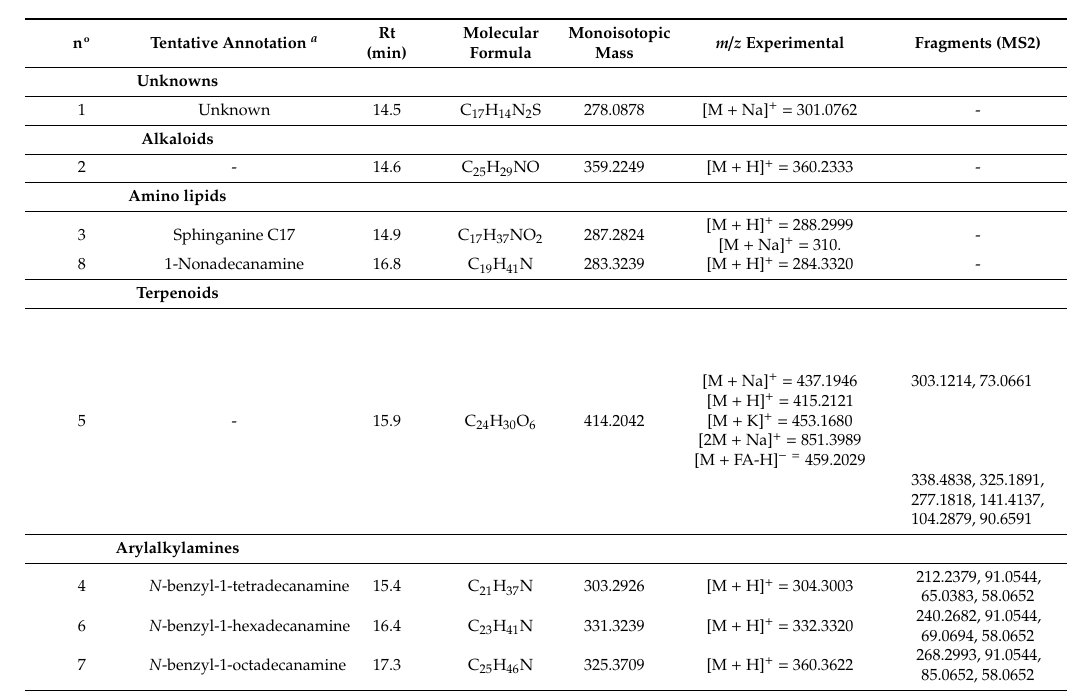
Table 4. Retention times, mass spectral data and characterizations of the detected compounds in the UHPLC / ESI–QTOF–MS analysis in positive and negative ionization